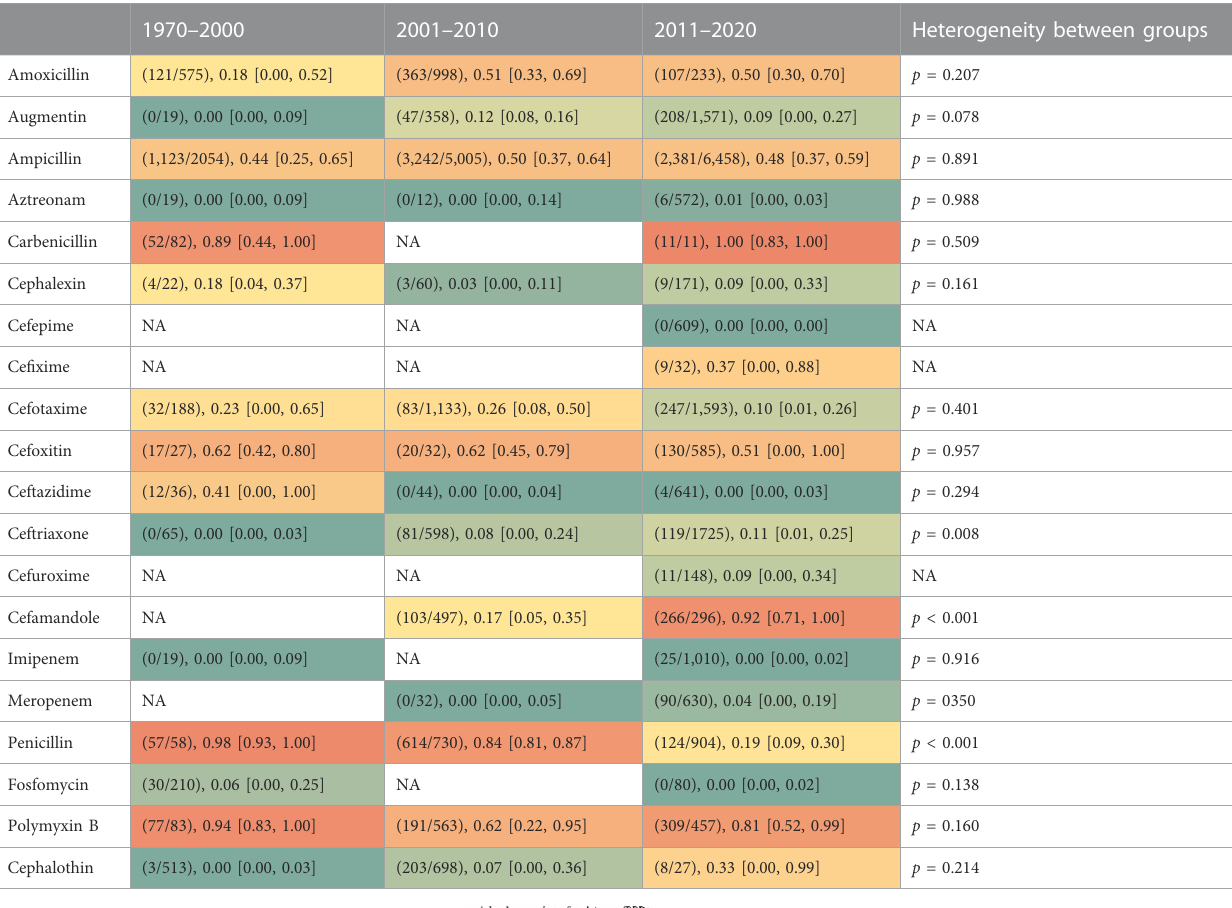
TABLE 4 Pooled Proportion of Vibrio cholera antibiotic resistance over the years.